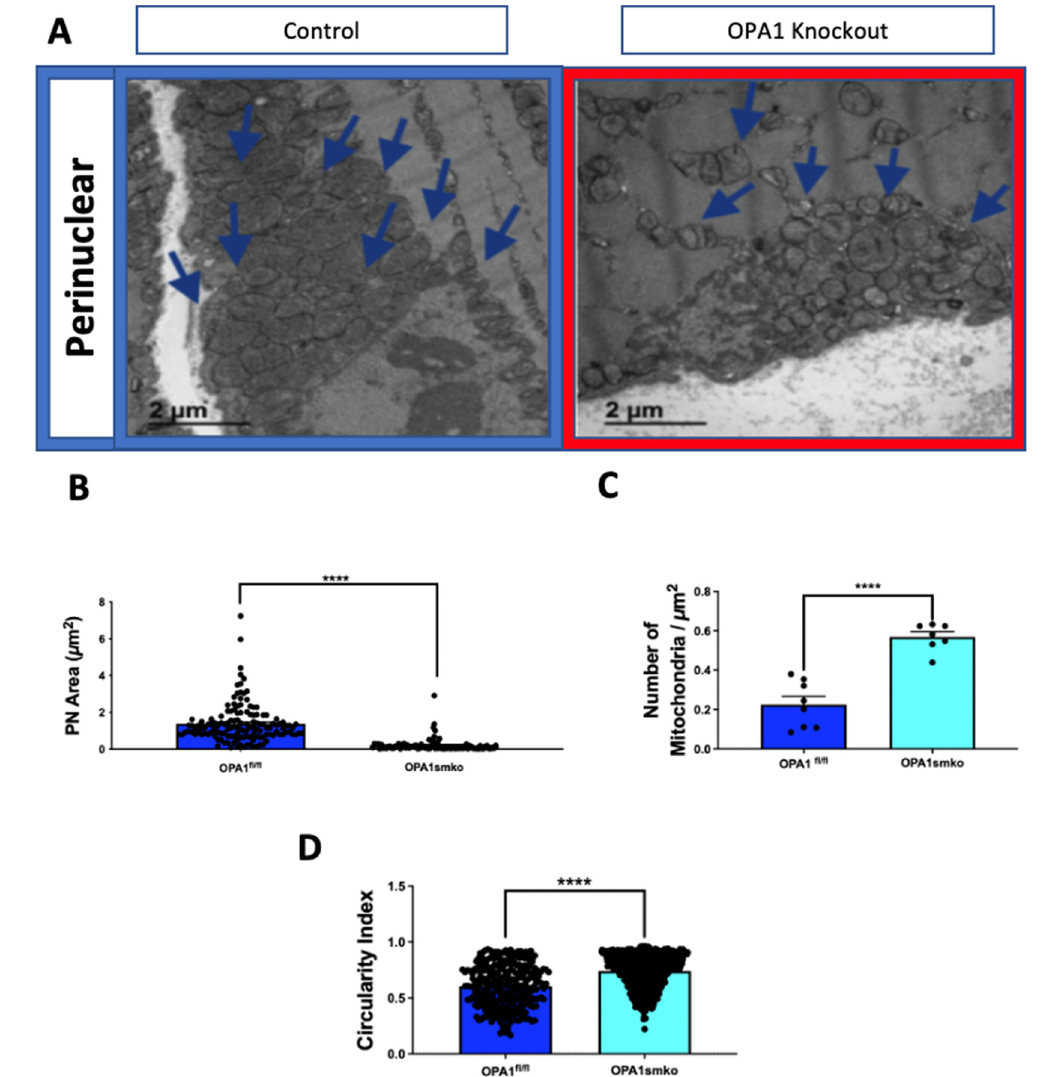
Figure 3. Knockdown of optic atrophy protein-1 ( OPA1) decreases mitochondrial area. ( A ) Representative TEM images of mitochondria in mouse skeletal muscle tissue from OPA1 knockdown (red outline) and control (blue outline) tissue. ( B ) Quantification of perinuclear mitochondrial area, ( C ) number of mitochondria per square micron, and ( D ) mitochondrial circularity index. Statistical significance is indicated by asterisks; ***** indicate p ≤ 0.0001.